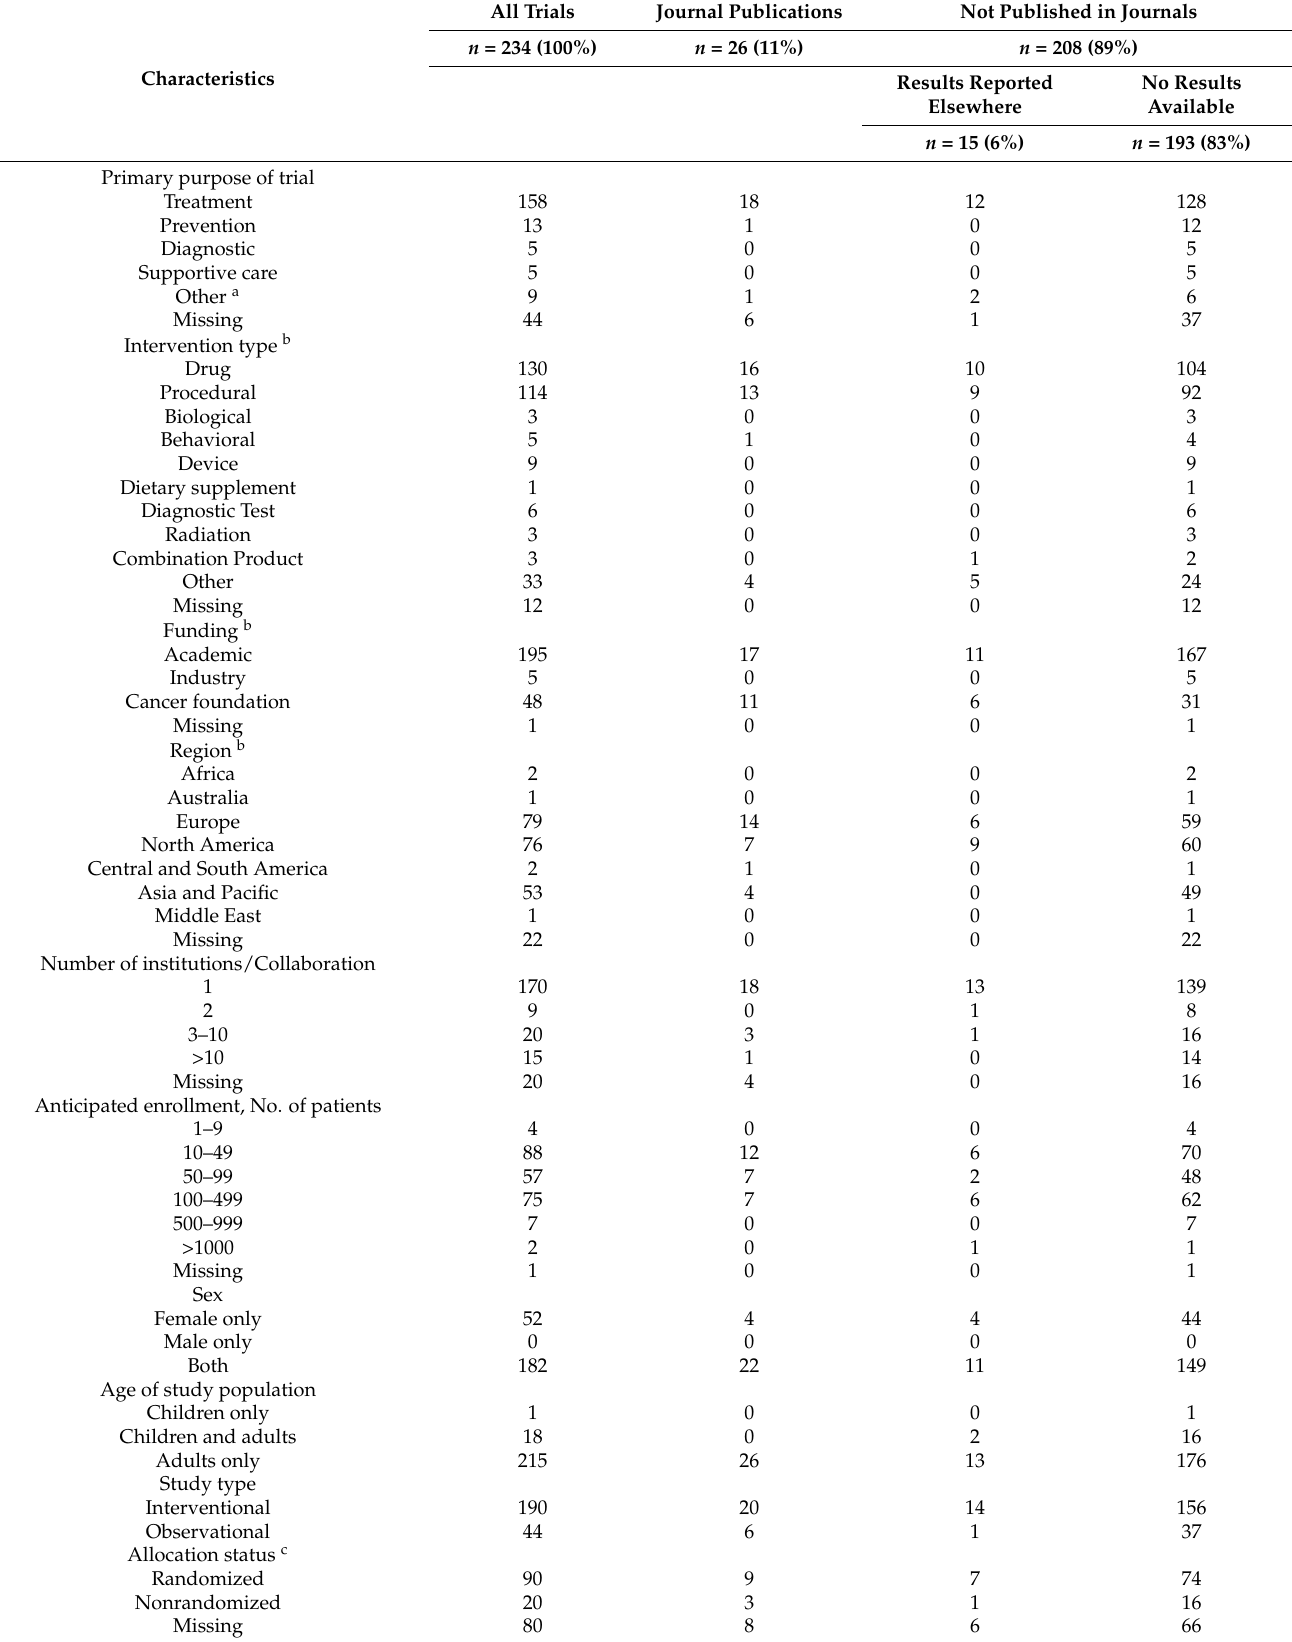
Table 1. Characteristics of HIPEC trials registered in